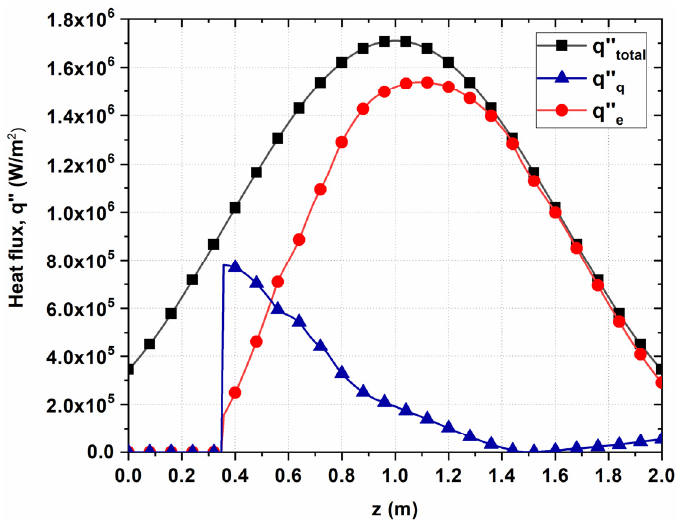
Figure 11. Variation in total applied heat flux, evaporative heat flux, and quenching heat flux with axial length (135°).